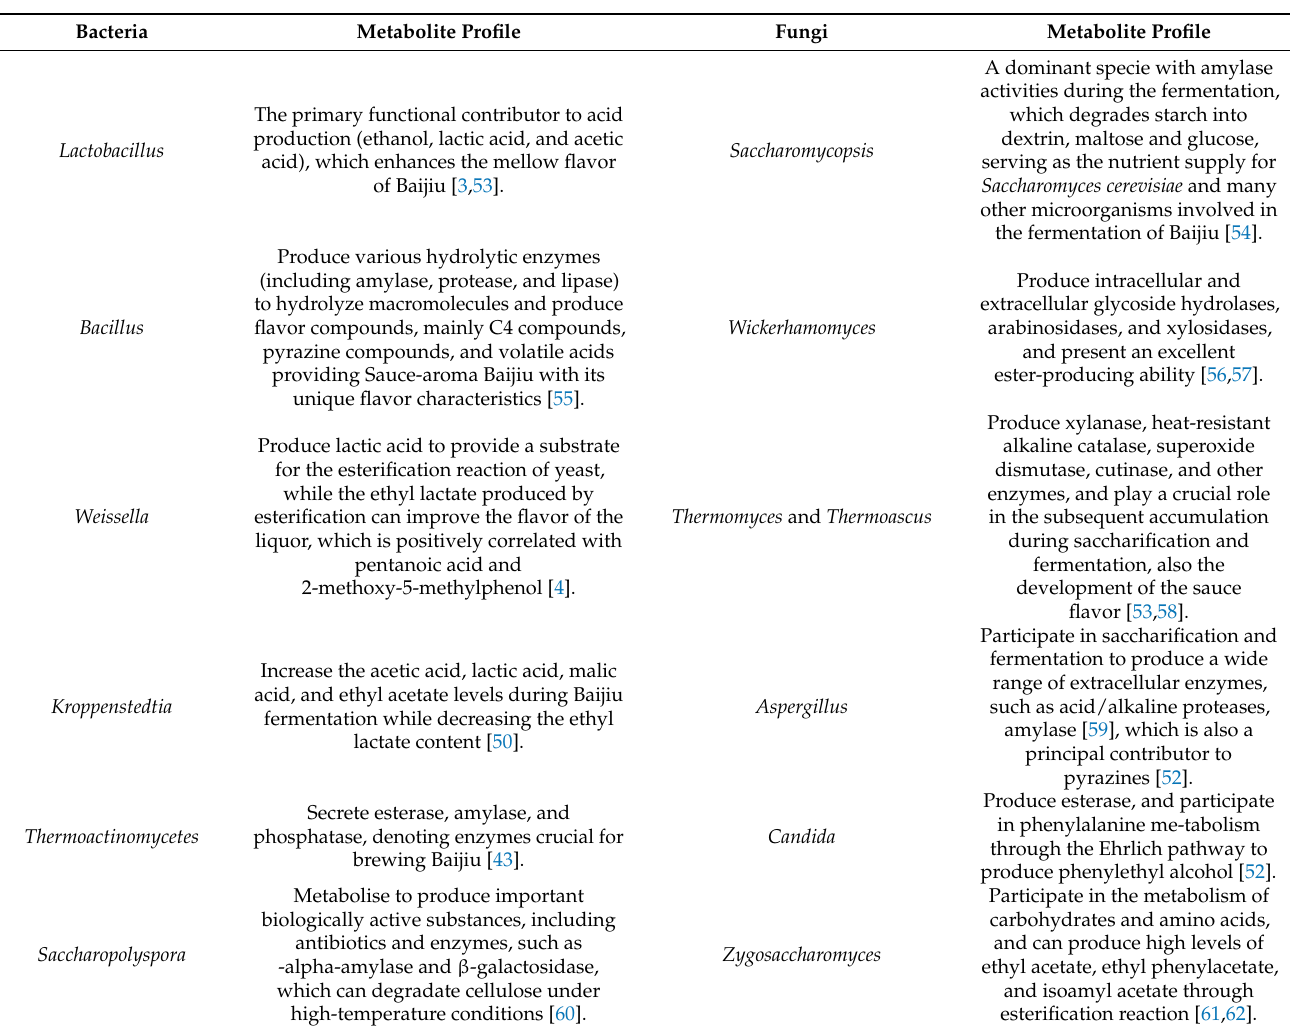
Table 2. The correlation between main microbial communities and their metabolite